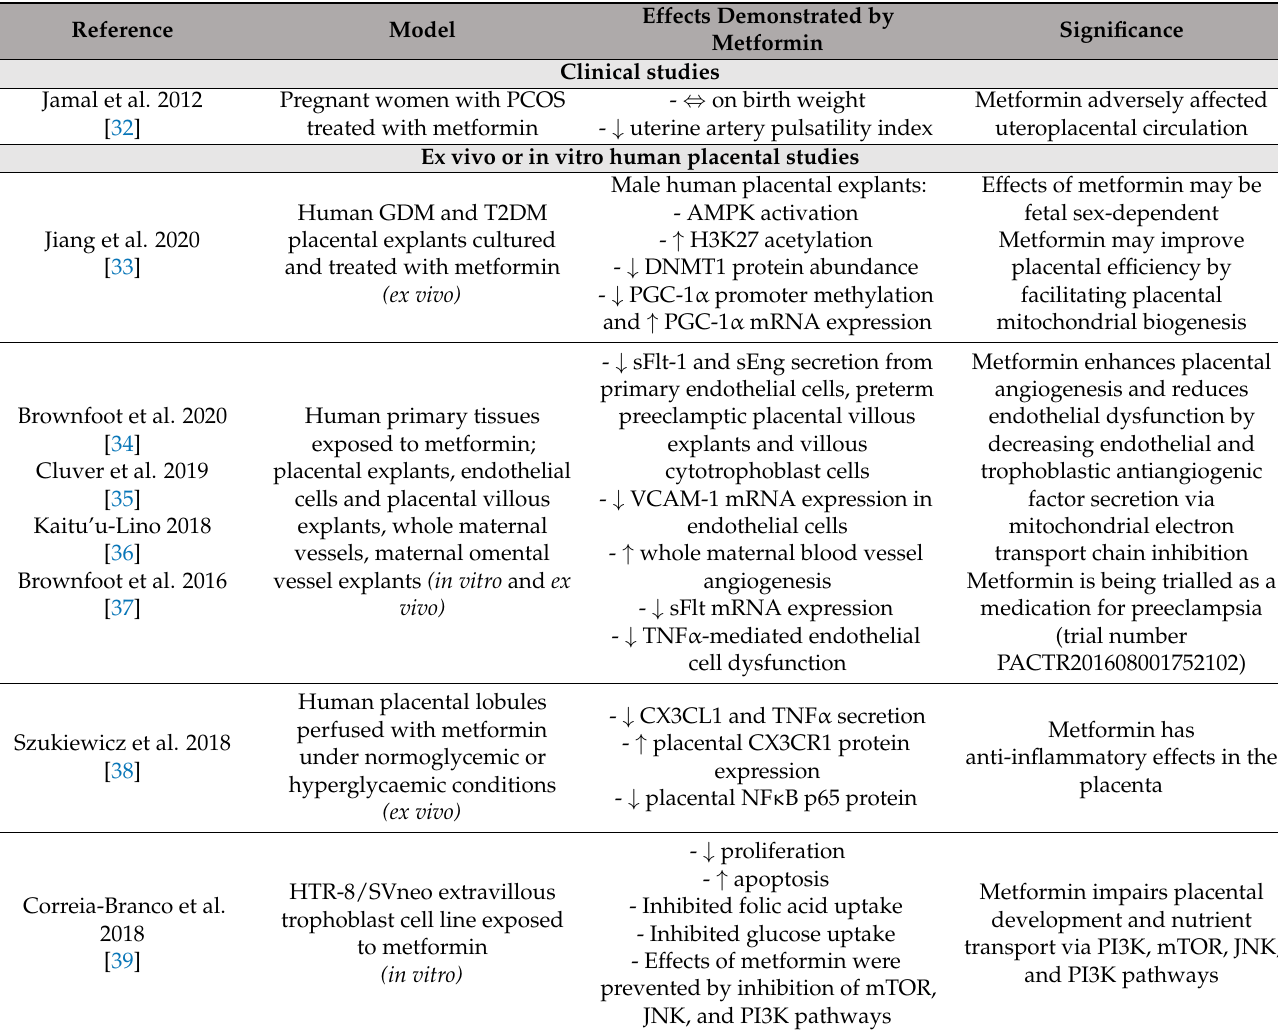
Table 1. Current literature on the impact of metformin on placental gene expression and function [32–43].